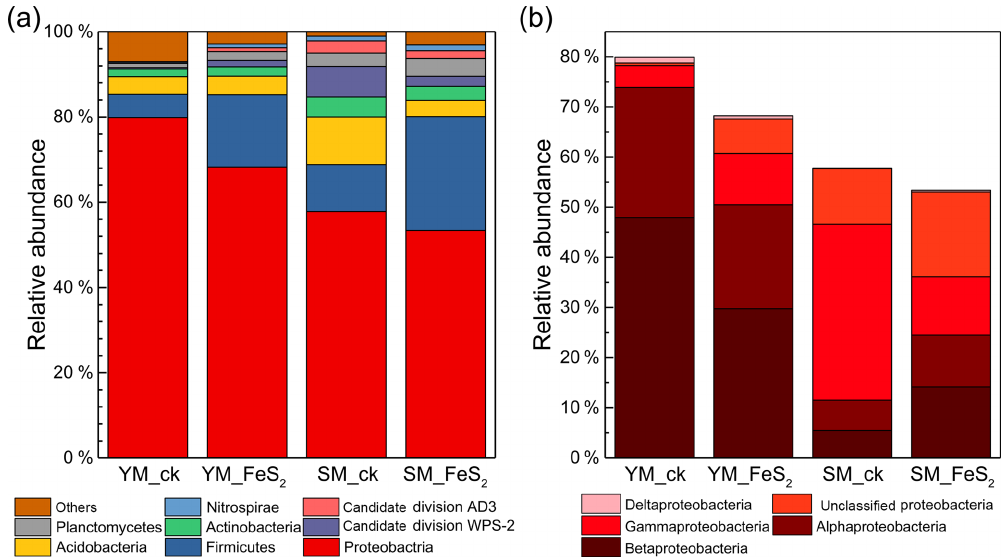
Figure 3. Relative abundances (percentages) of the main bacterial taxonomic groups identified, i.e., Proteobacteria, Firmicutes, Acidobacte- ria, Actinobacteria, candidate division WPS-2, Planctomycetes, candidate division AD3, and Nitrospirae (a) , and classes Alphaproteobacte- ria, Betaproteobacteria, Deltaproteobacteria, and Gammaproteobacteria (within the phylum Proteobacteria) (b) . For each tailing sample, the relative abundances of the sequences assigned to a given taxonomic unit were calculated for each of three subsamples, and the average value was then used to represent the relative abundance of each tailing